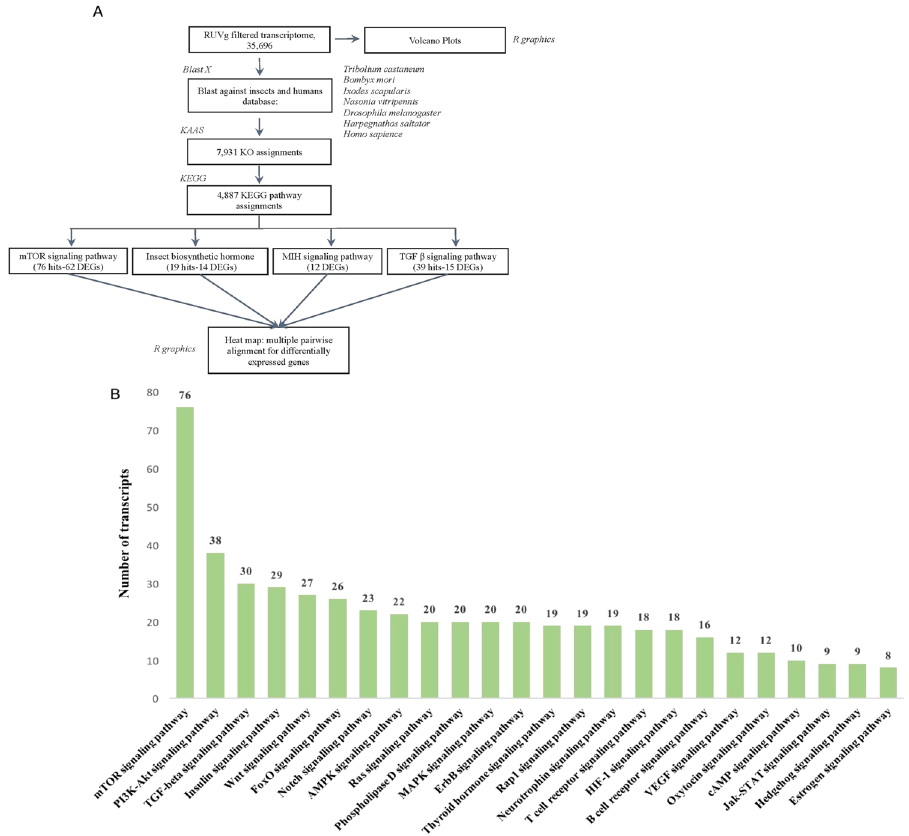
Figure 3. Functional characterization of YO transcriptome. ( A ) Pathway annotation pipeline using KAAS for KEGG pathway assignments. Six related insect species genomes (italics) were used for KO and pathway assignments. ( B ) Comparison of land crab YO contigs associated with selected second-tier KEGG pathways in the signal transduction